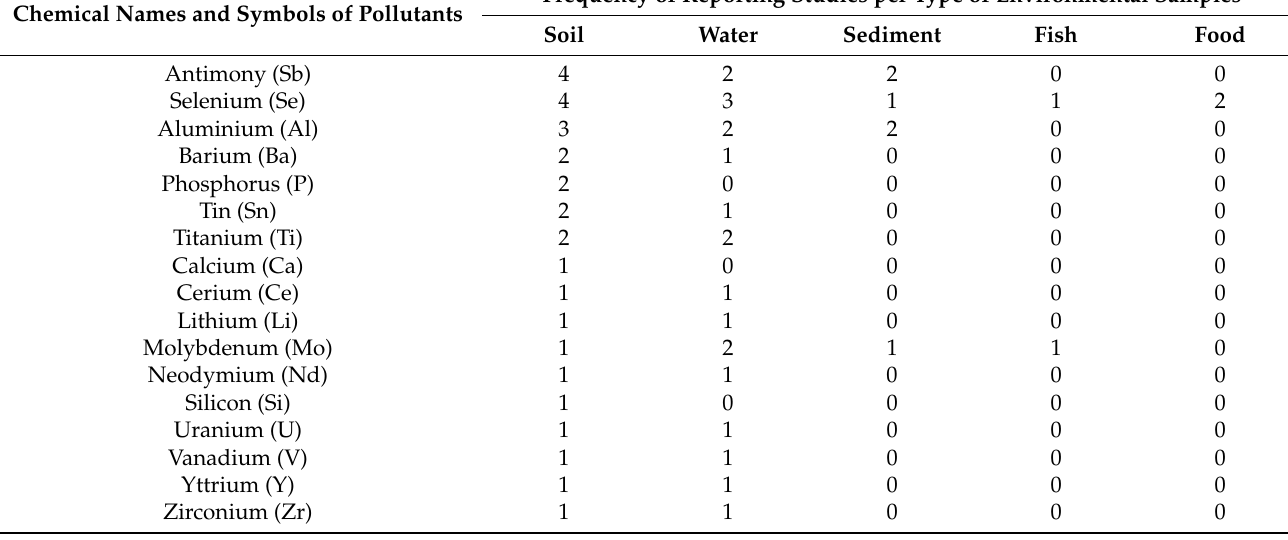
Table A2. Type of environmental pollutants and frequency of reporting studies in soil, water, sediment, fish, and food samples. Frequencies are given for pollutants reported in up to four studies,